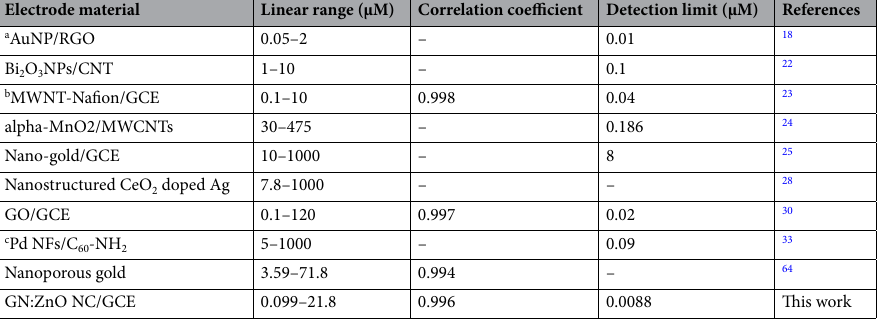
Table 1. Comparison of the performances of different electrochemical sensors for p-nitrophenol. a Gold nanoparticle/reduced graphene oxide, b Multi-wall carbon nanotubes, c Palladium nano-flowers supported on